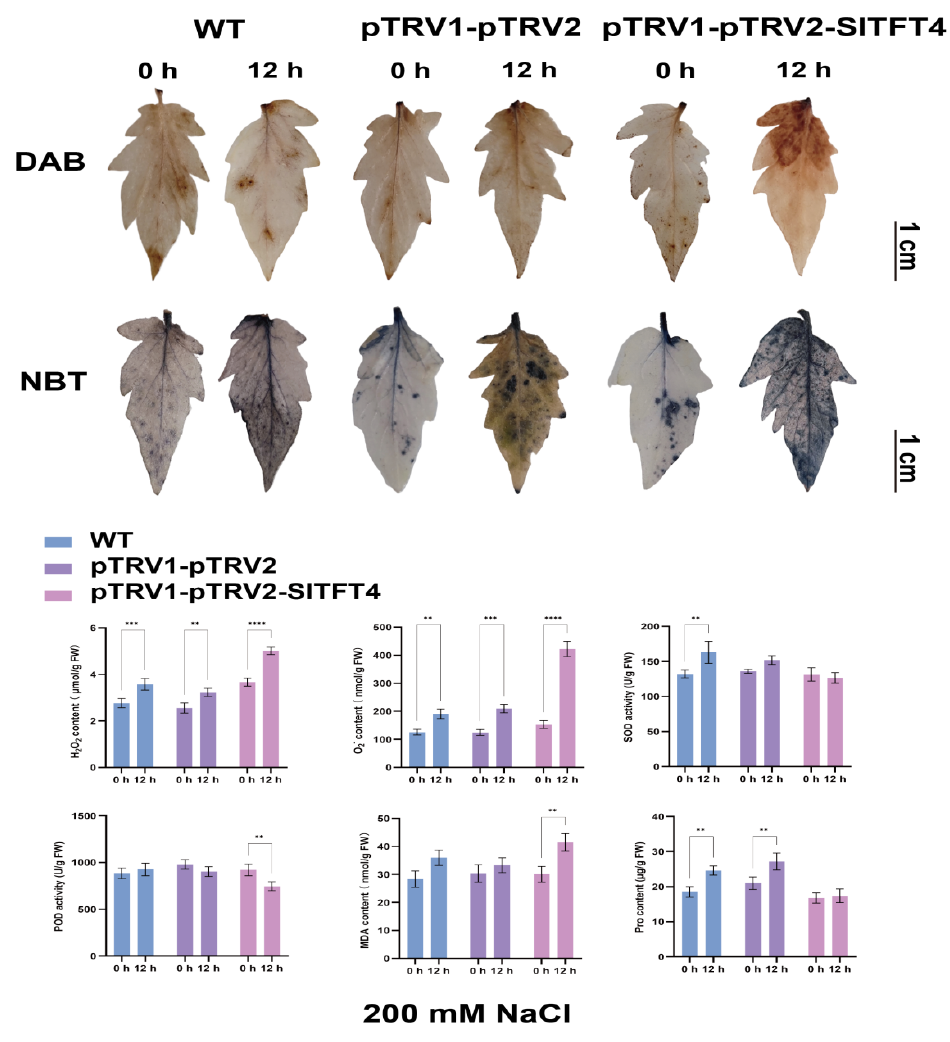
Figure 13. DAB and NBT staining and physiological indices in leaves of different tomato plants under salt stress. WT: untreated wild type plants, pTRV1-pTRV2: control plants injected with an empty vector, pTRV1-pTRV2-SlTFT4: treated plants injected with an SlTFT4 silencing vector. The upper part of the figure shows the DAB and NBT staining of the leaves under different treatment periods of salt stress. The scale bar of the leaves is 1 cm. The physiological indexes of the leaves under different treatment periods of salt stress are measured below. Error bars are the standard SD of three independent biological replicates, presented as mean ± SD. The statistical significance of differences was confirmed by Dunnett’s multiple comparison test (** p < 0.01, *** p < 0.001, and **** p < 0.0001).